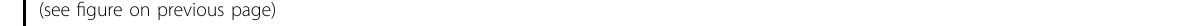
Fig. 4 NUDT3-AS4 is physically associated with the miR-99s. a Bioinformatics prediction of miR-99s binding sites at two distinct positions in NUDT3-AS4. b Schematic diagram of NUDT3-AS4 isoforms from ENSEMBL annotation. c NUDT3-AS4 expression in breast cancer and nontumorigenic cell lines. d NUDT3-AS4 knockdown reduces mRNA ( d ) and protein ( e ) levels of AKT1 and mTOR. MDA-MB-231 cells were retrovirally transduced with NUDT3-AS4_sh or control. RT-PCR was performed to measure NUDT3-AS4, miR-99s, and the mRNA of AKT1 and mTOR level, respectively. Immunoblots were performed to determine the protein levels of AKT1 and mTOR. f , g NUDT3-AS4 overexpression increases mRNA ( f ) and protein ( g ) levels of AKT1 and mTOR. MDA-MB-231 cells were transfected with NUDT3-AS4 WT or the respective mutants. RT-PCR and WB analysis were performed to measure the mRNA and protein level, respectively. ** P < 0.01, *** P < 0.001 versus control. h miR-99s abolish NUDT3-AS4 caused protein levels increase of AKT1 and mTOR. i A schematic representation of NUDT3-AS4. The putative miR-99s binding sites in the NUDT3-AS4 are shown in red and blue boxes. j A schematic representation of luciferase reporter of WT or consecutive mutation of NUDT3-AS4 constructs. k miR-99s do not change the luciferase activity of NUDT3-AS4 WT. MDA-MB-231 were cotransfected with miR-99s and luciferase reporters containing NUDT3-AS4 WT or mutant transcript. Data are presented as relative luciferase activity of Renilla to Fire fl y luciferase luciferase activity ( n = 3). l A schematic outline of the MS2-RIP strategy used to identify endogenous NUDT3-AS4 binding complex. m Endogenous association of microRNAs with NUDT3-AS4 after MS2-RIP. MDA-MB-231 cells were transiently transfected with GST-fused MS2 binding protein (GST-MS2BP) together with pTAG2B-MS2-12XH19 or pTAG2B-MS2-12X (empty vector; MS2). Total cell extracts were prepared 24 h after transfection and precipitated by glutathione-sepharose beads. RNA was puri fi ed and analyzed by RT-qPCR to detect transfected NUDT3-AS4 or endogenous miR-99s. n NUDT3-AS4 knockdown inhibits MDA-MB-231 cells proliferation. o Dissociation of mammospheres after transfection with NUDT3-AS4 and miR-99s mimics. The results represent the mean diameter of mammospheres ± SD, n = 6. * P < 0.05; ** P < 0.01 versus NUDT3-AS4 negative; ## P < 0.01 versus NUDT3-AS4 positive; NS not signi fi